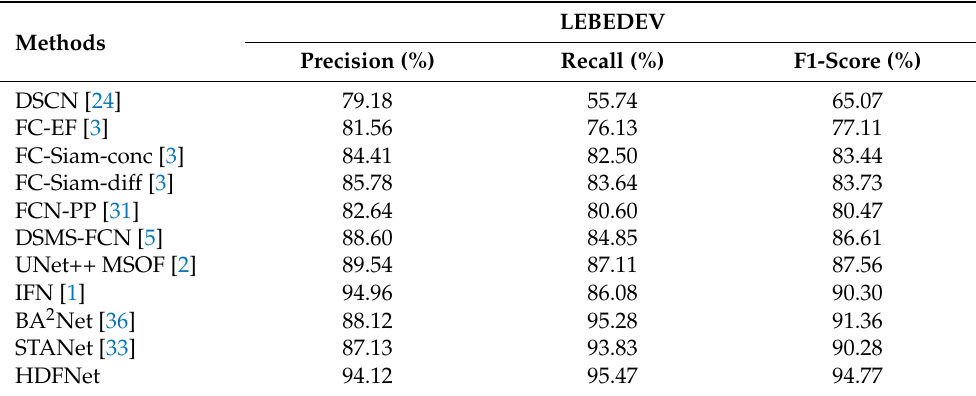
Table 1. Result Comparison on dataset